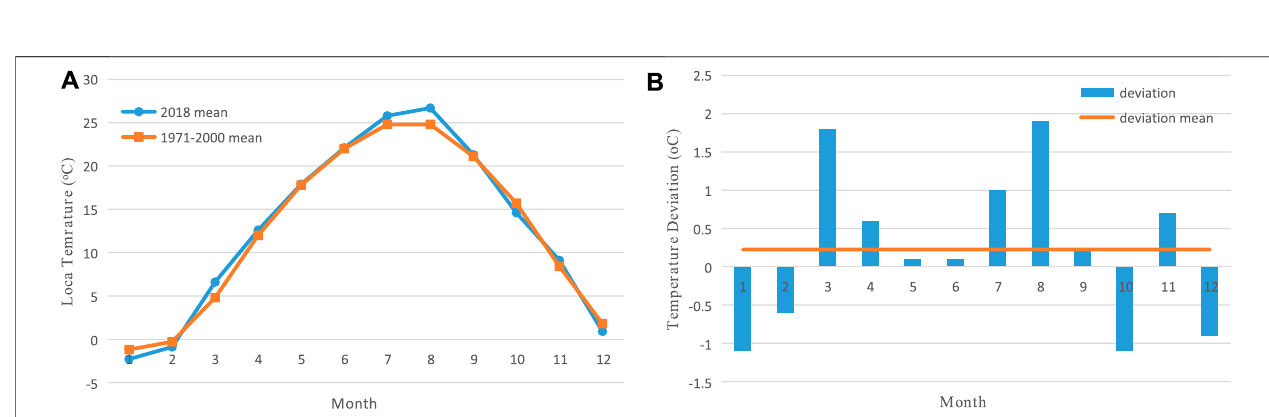
( Table 7 ). The complete target layer grading results show that the